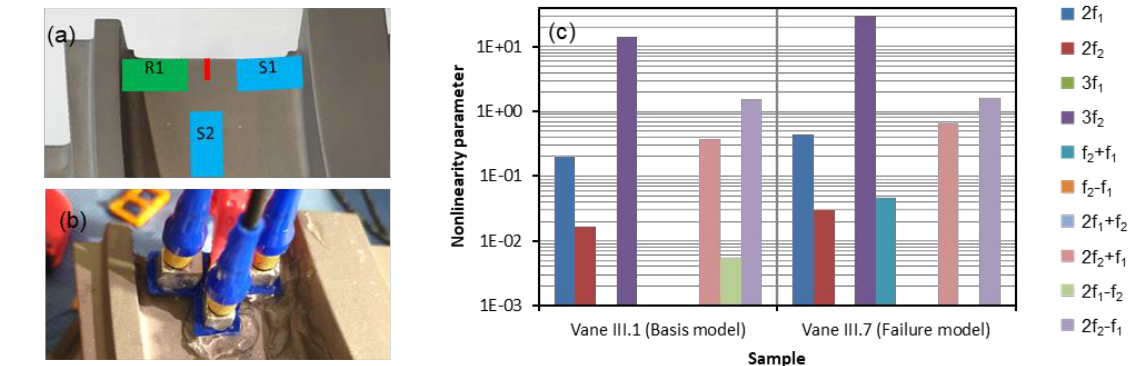
Figure 30. Nonlinearity parameter, 90 ◦ sensor orientation, f 1 = 4 MHz, f 2 = 5 MHz: ( a ) Sensor Figure 30. Nonlinearity parameter, 90° sensor orientation, f 1 = 4 MHz, f 2 = 5 MHz: ( a ) Sensor Figure 30. Nonlinearity parameter, 90° sensor orientation, f 1 = 4 MHz, f 2 = 5 MHz: ( a ) Sensor orientation; ( b ) Experimental setup; ( c ) Comparison of nonlinearity orientation; ( b ) Experimental setup; ( c ) Comparison of nonlinearity parameter. orientation; ( b ) Experimental setup; ( c ) Comparison of nonlinearity parameter. Figure 30. Nonlinearity parameter, 90° sensor orientation, f 1 = 4 MHz, f 2 = 5 MHz: ( a ) Sensor orientation; ( b ) Experimental setup; ( c ) Comparison of nonlinearity parameter.